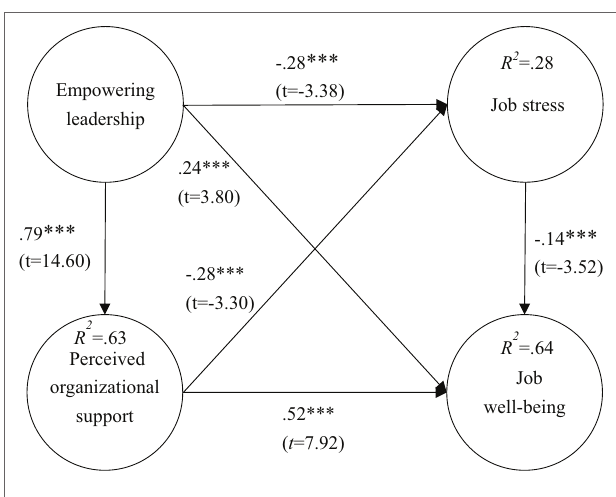
FIGURE 2 | Validation of the research model. *** p <